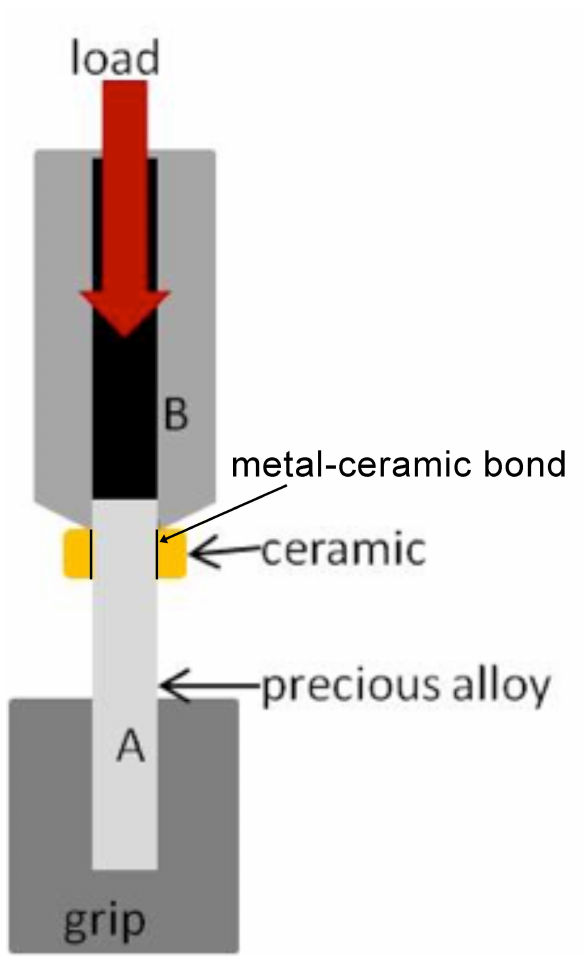
Figure 3: Schematic of the testing system